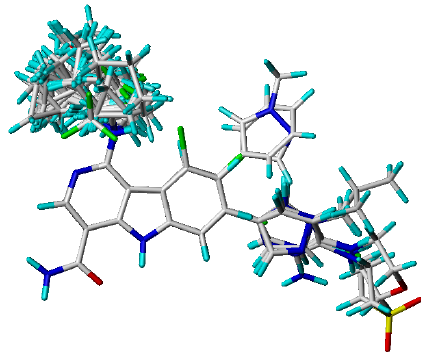
Figure 5. Superimposition of compounds for CoMFA and CoMSIA